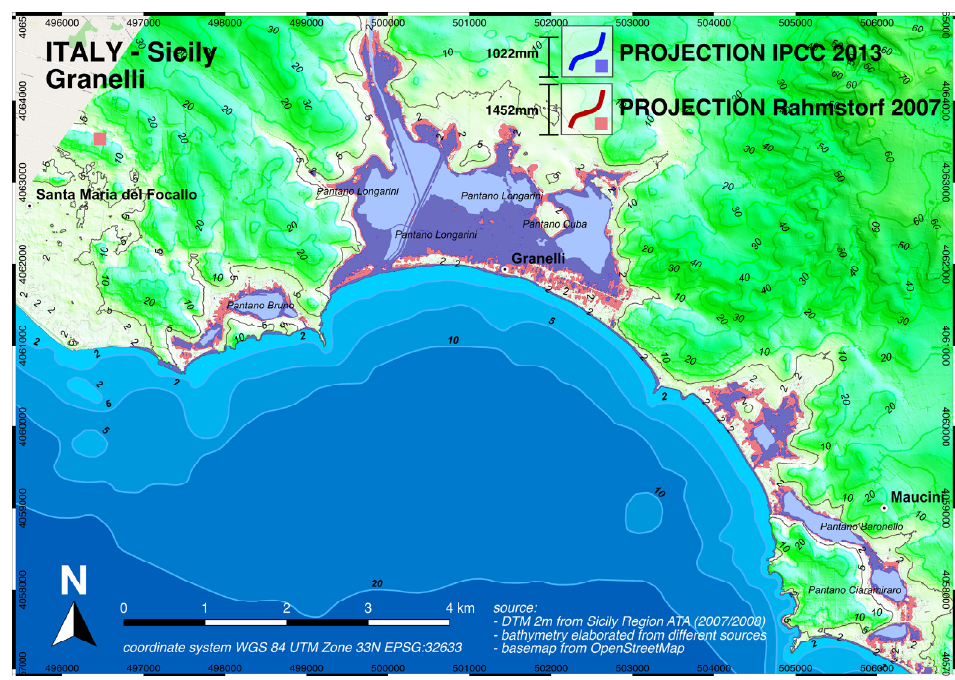
Figure 6. Map 12 Granelli (Sicily, Italy), see also Figure 1 for location). The potential submersion area, using Rahmstorf 2007 projections are 6.8 km 2 .